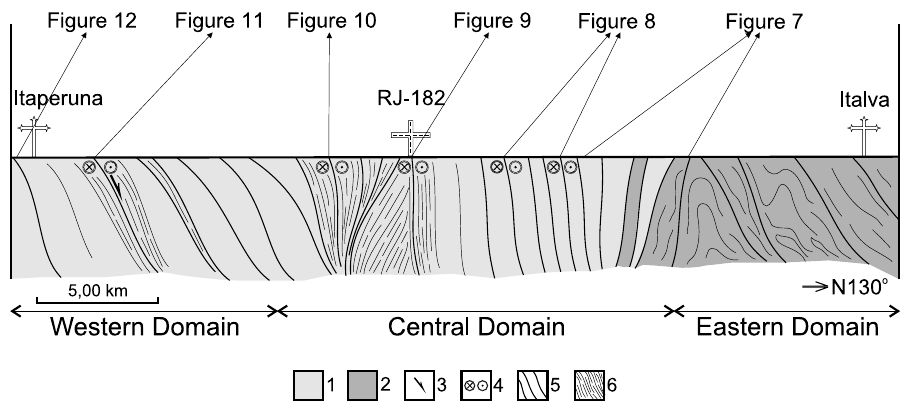
Fig. 2 – Italva-Itaperuna geologic profile. Legend: 1 – Paraíba do Sul Complex; 2 – Paraíba do Sul Complex – carbonated series; 3 – Sense of shear in profile; 4 – Dextral shear zones; 5 – Foliation parallel to composicional layering; 6 – Mylonitic